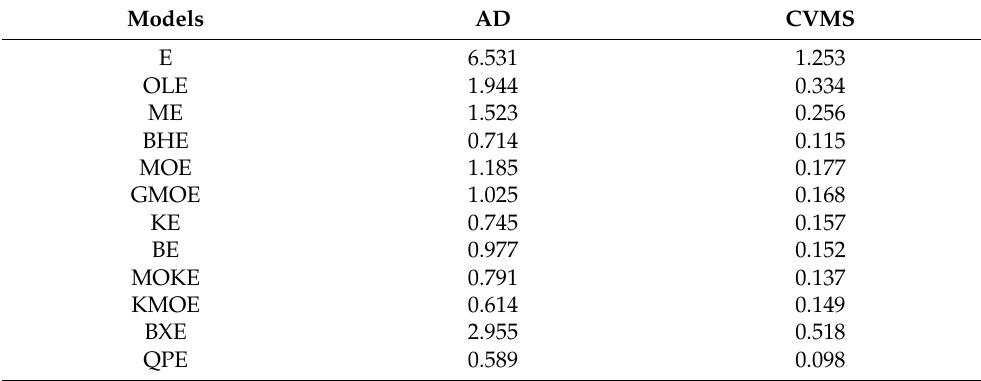
Table 9. AD and CVM for survival